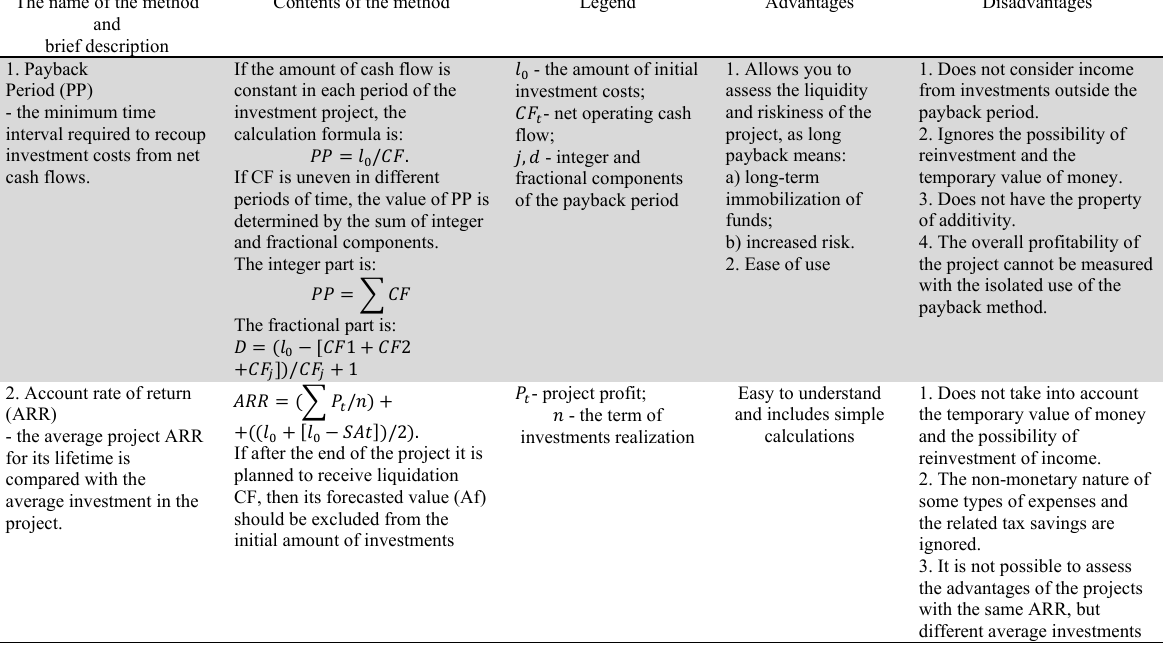
Analysis of single-criteria methods of evaluating the economic efficiency of investment projects The name of the method